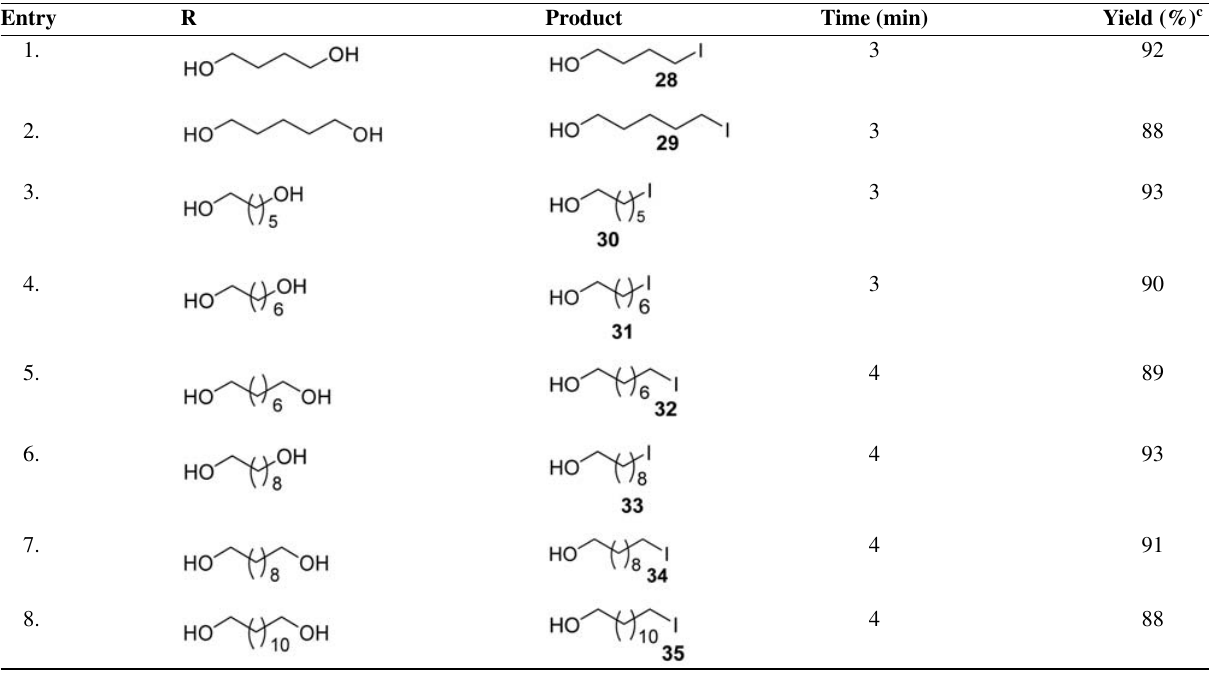
Table 2. Mono-iodination of diols a,b